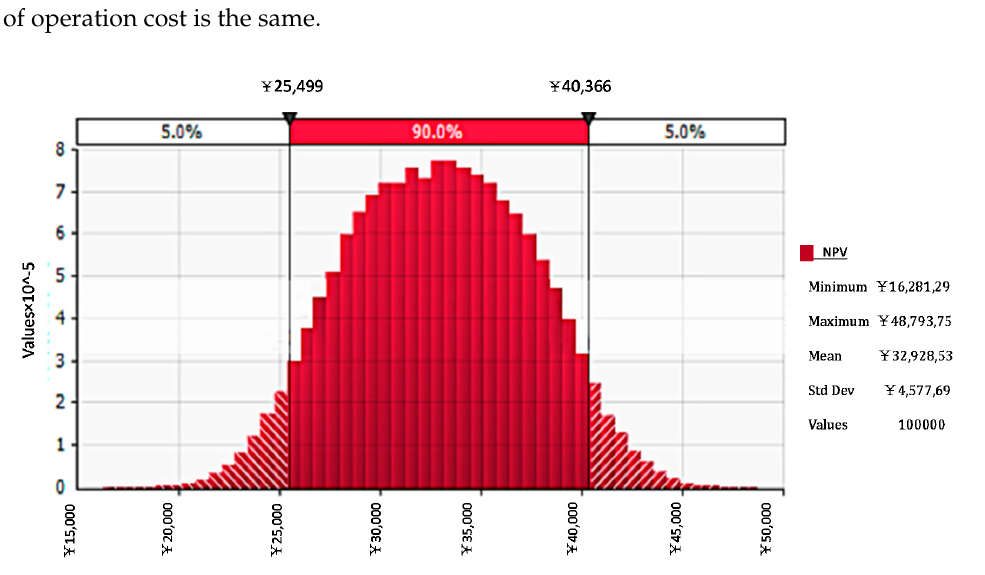
Figure 5. Impact of capital cost on changes in net present value (NPV).